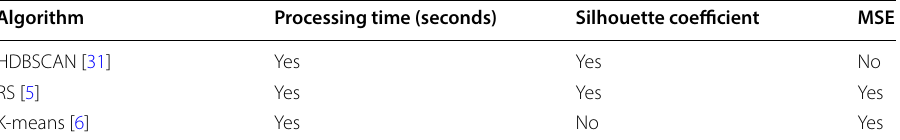
Table 4 Extracted factors for each algorithm Algorithm